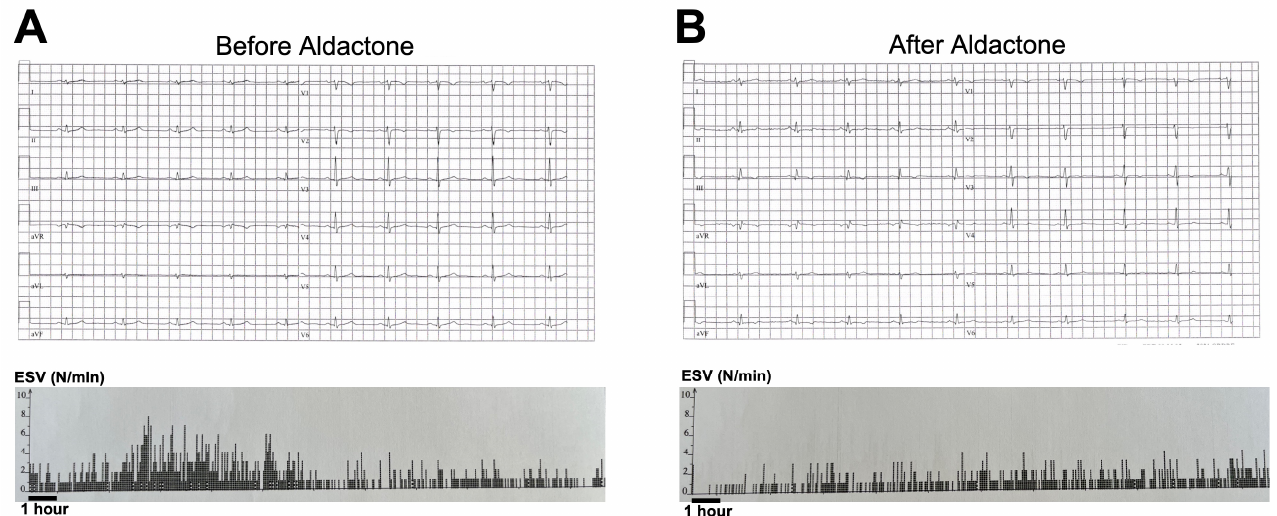
Figure 1. ECG after prescription of Aldactone in one ACM patient. ( A ) Example of ECG and PVB recording before Aldactone and ( B ) after Aldactone in a mutated desmoplakin (DSP) patient.